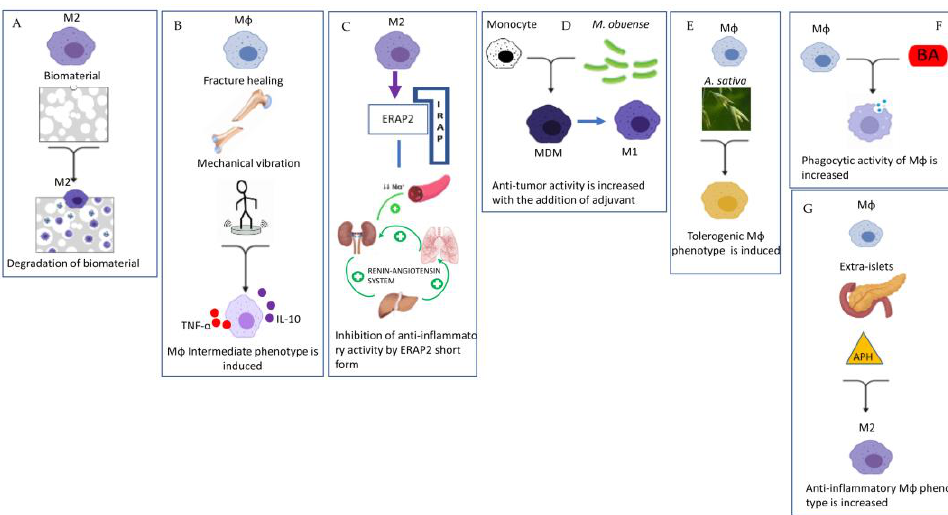
Figure 2. Representative pictures of the seven experimental papers published in the Special Issue. This figure was generated with BioRender and PowerPoint. ( A ) Degradation of biomaterial by Mϕ depends on the consistency of the biomaterial itself [5]. ( B ) Mechanical vibration induced an intermediate Mϕ phenotype in fracture healing [6]. ( C ) ERAP2 short form caused an inhibition of anti-inflammatory ativity of Renin Angiotensin System [7]. ( D )Anti-tumor ativity is increased with the addition of adjuvant M. obuense [8]. ( E ) A. sativa induced a tolerogenic Mϕ phenotype [9]. ( F ) Bempedoic acid (BA) increased phagocytic activity of Mϕ [10]. ( G ) Sodium aminophthalhydrazide (APH) increased anti-inflammatory phenotype in the pancreas [11].